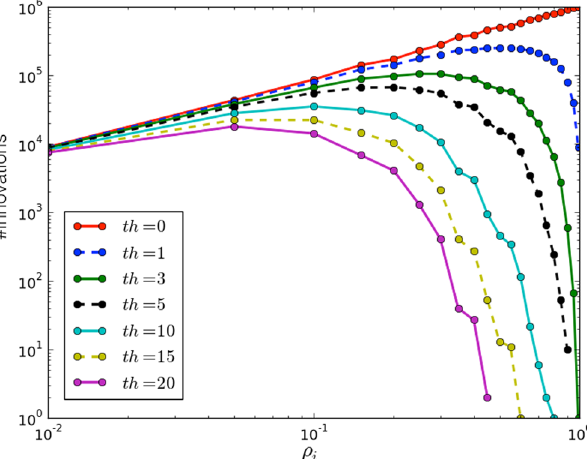
Figure 1. Number of innovations as function of innovators’ density (i.e. ρ i ) in a population with N = 1000 agents. Each curve illustrates results achieved using a different threshold Th . This threshold is used to quantify the amount of innovation of a proposal (e.g., the number of citations in a scientific context or the number of implementations of a new technology). The main role of Th is to link the emergence of novelties with the existence of a community of developers able to put them into practice. Results have been averaged over different simulation